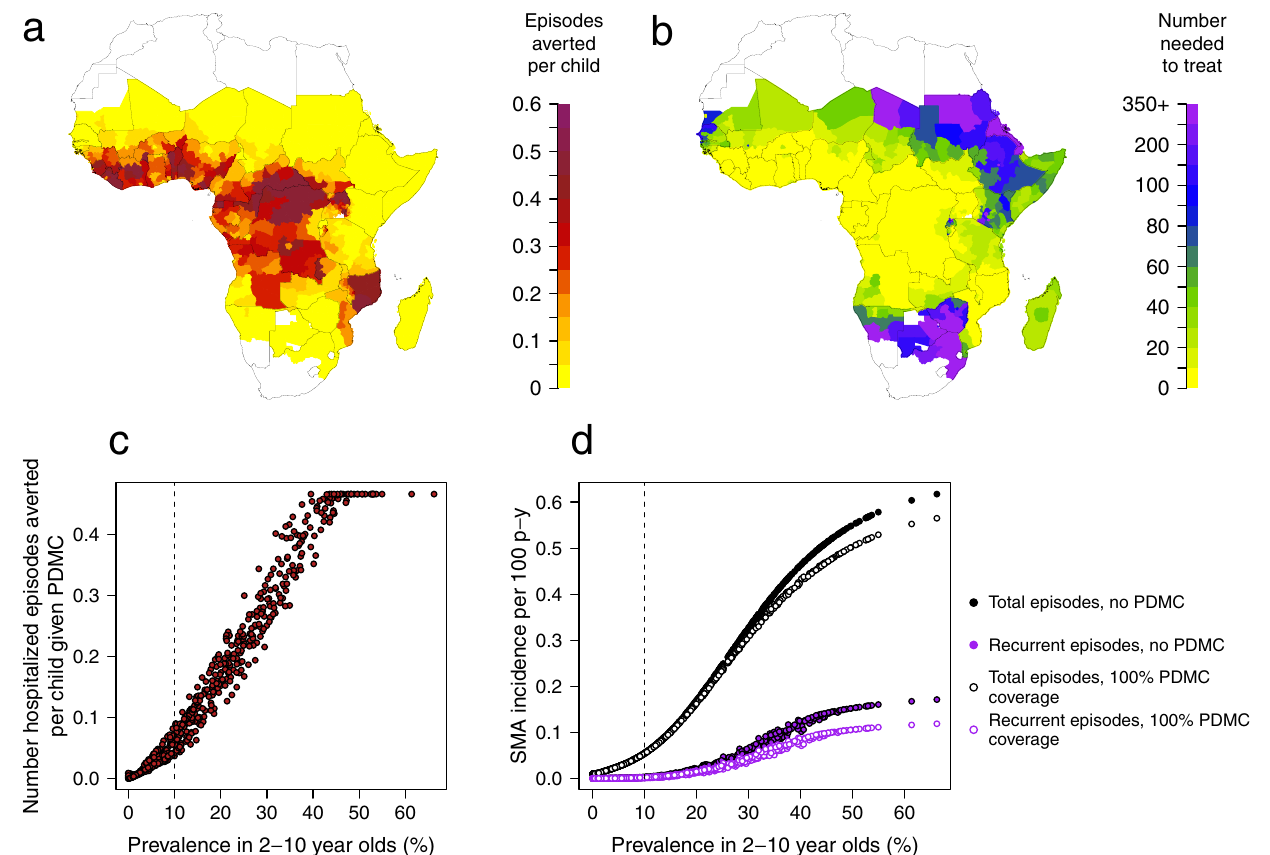
Fig. 3 | Impact of PDMC. a Average number of hospitalised malaria episodes avertedduring the 6 months post-discharge period per child aged 0 – 5 years given PDMC. b Number needed to treat with PDMC to avert 1 malaria episode requiring hospitalisation. All estimates are shown for subnational (administrative area 1) regions and incorporate imperfect adherence to the three prescribed courses of PDMC as observed in ref. 23 . The assumption in these results is that 50% of cases requiring hospitalisation access hospital care, but there is negligible change in theseoutputswhenthispercentageisvariedfrom30 – 70%. c Parasiteprevalencein 2 – 10-year old versus average number of hospitalised malaria episodes averted during the 6 months post-discharge period per child aged 0 – 5 years given PDMC (results from a ). Dashed line indicates parasite prevalence above which